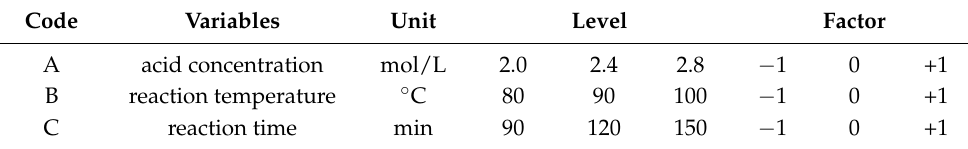
Table 3. Experimental variables and levels used in the response surface design.